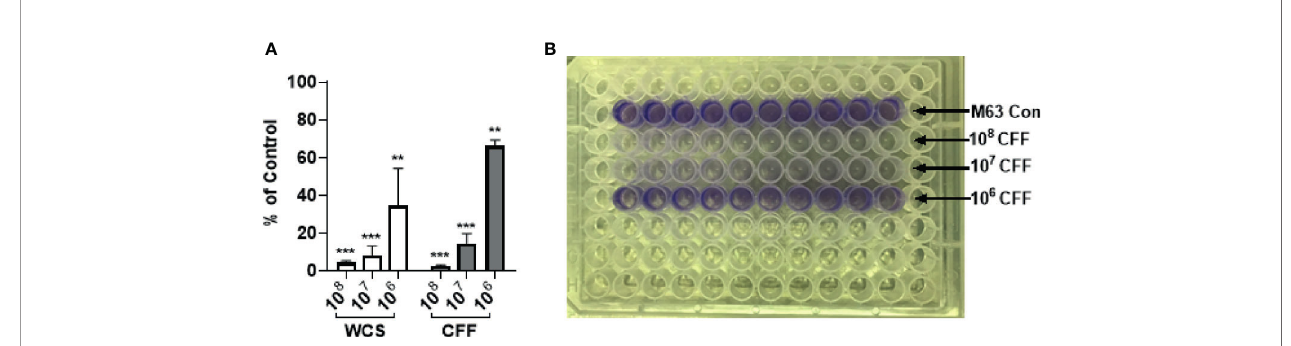
FIGURE 1 | L. acidophilus whole cell suspension (WCS) and cell free fi ltrate (CFF) inhibited P. aeruginosa bio fi lm formation. P. aeruginosa cultures were incubated with L. acidophilus 10 6 – 10 8 CFU/200 µL WCS or CFF at 37°C for 24 h. Apical bio fi lms were stained with 0.1% crystal violet and absorbance (OD 600 ) was measured to quantify bio fi lm formation. (A) All three concentrations of L. acidophilus WCS signi fi cantly reduced bio fi lm formation in a concentration-dependent manner. Similarly, all CFF concentrations signi fi cantly prevented bio fi lm formation and demonstrated a dose response. (B) Corresponding image of crystal violet stained 96-well plate at the end of bio fi lm formation experiment. Bio fi lm data are mean ± s.e.m. percent change from control. **p < 0.01, ***p < 0.001; WCS n = 5 independent experiments; CFF n = 3 independent experiments.